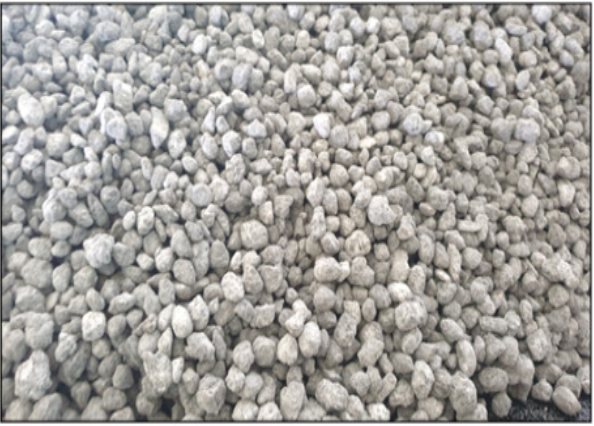
Figure 5. The manufacturing process of pellet-type asphalt pavement and pictures of paving mate- rials.